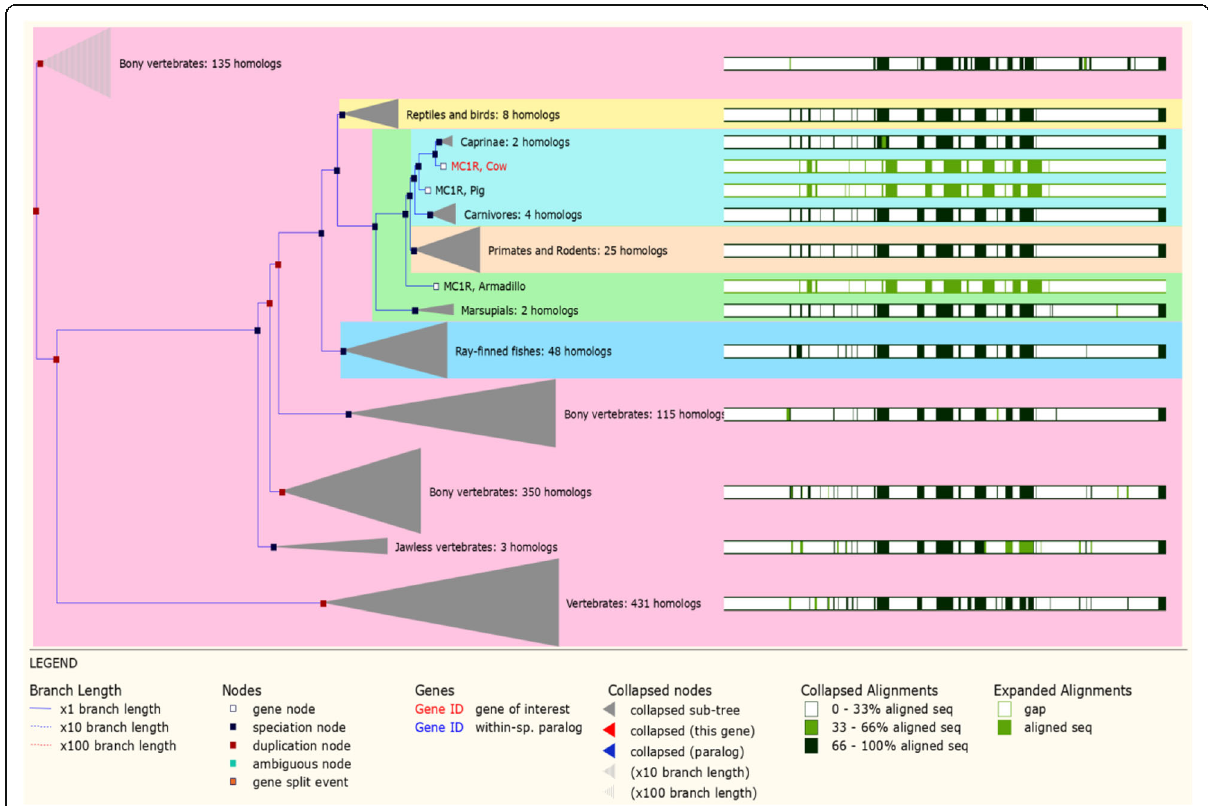
Fig. 5 MC1R gene tree homologs in different mammalian and